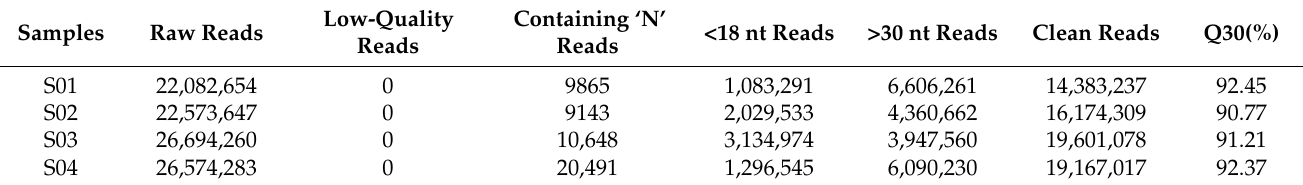
Table 1. Statistics of sRNA (small RNA) sequences from the four